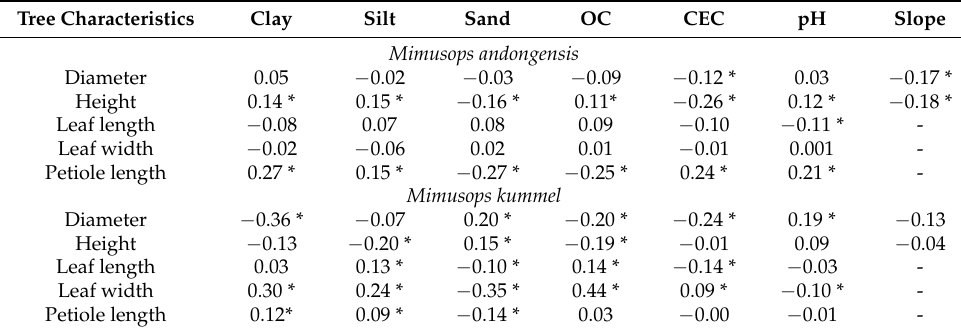
Table 6. Pearson correlation coefficients between tree and soil characteristics. Tree Characteristics